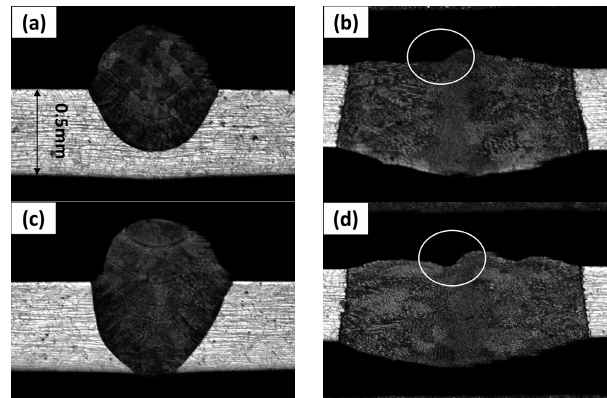
Figure 3. Defects of the welds: ( a ) τ = 3 ms; ( b ) τ = 9 ms; ( c ) f = 40 Hz; ( d ) f = 100 Hz.